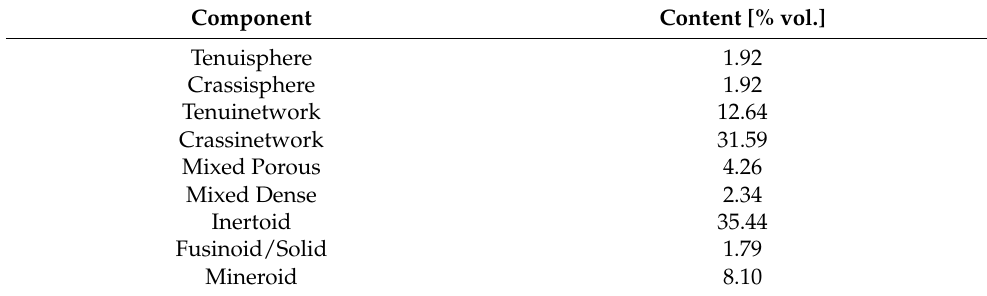
Table 5. Petrographic composition of chars. Reprinted with permission from [29] 2016 Elsevier. Component Content [% vol.] Tenuisphere